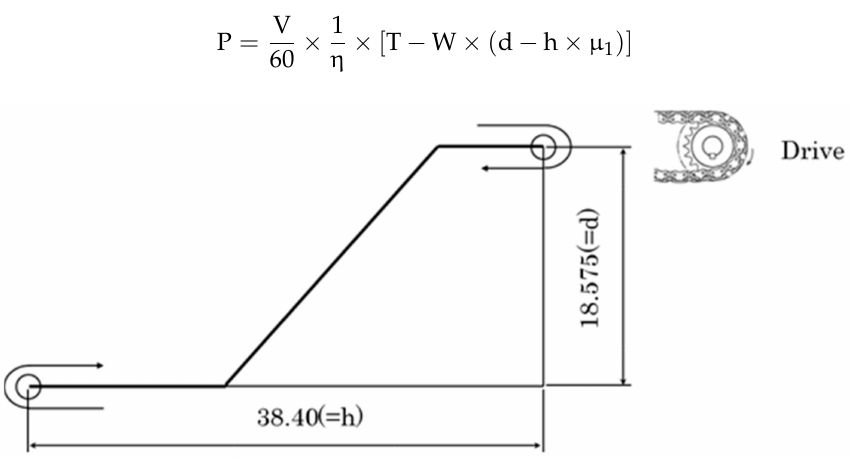
Figure 2. Layout of the roller chain